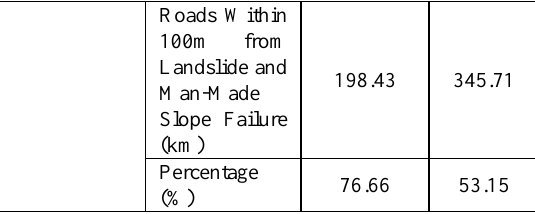
Figure 4: Landslide element at risk map of